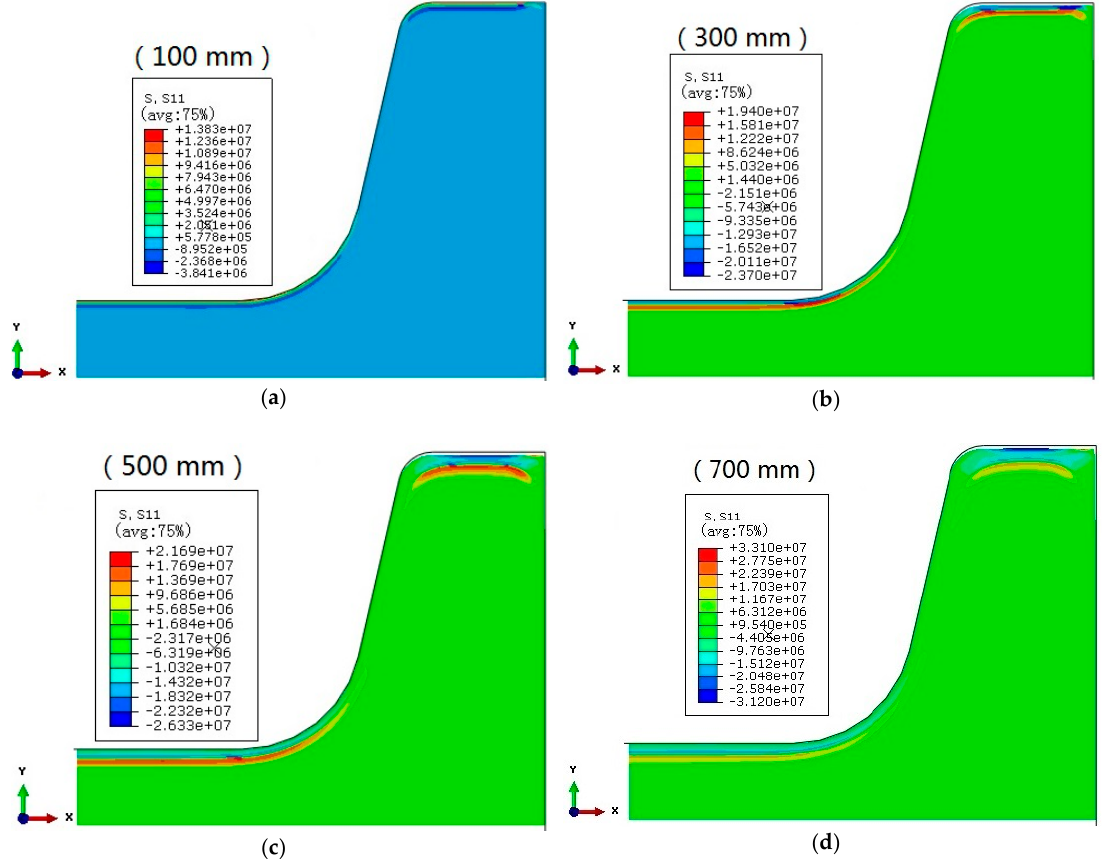
Figure 8. Stress contours along the X direction at depths from the meniscus of ( a ) 100 mm; ( b ) 300 mm; ( c ) 500 mm and ( d ) 700 mm in the mold.